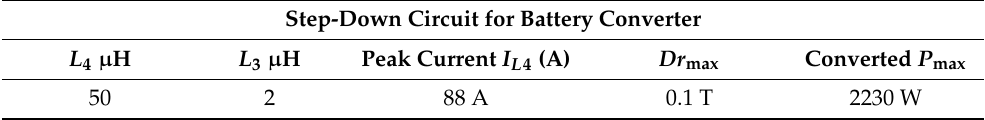
Table 3. Design parameters obtained for the step-down mode of the